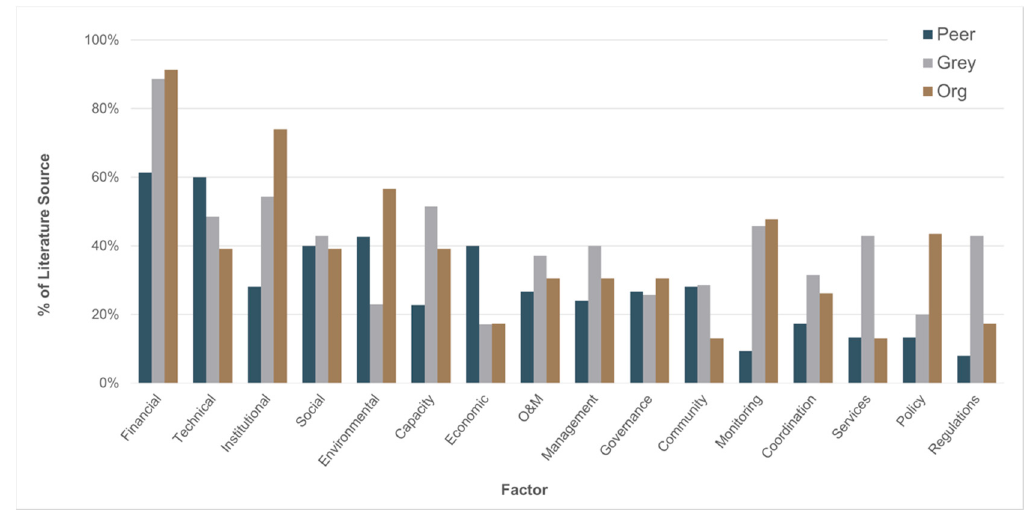
Figure 3. Relative frequency of factors referenced in at least 20% of all studies listed in descending order of frequency of total references from all literature sources (peer-reviewed = 75; grey = 35; organizational (org) =